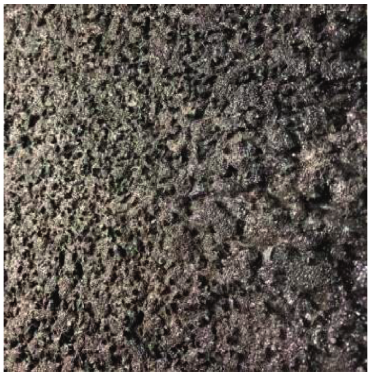
Figure 11: Premix